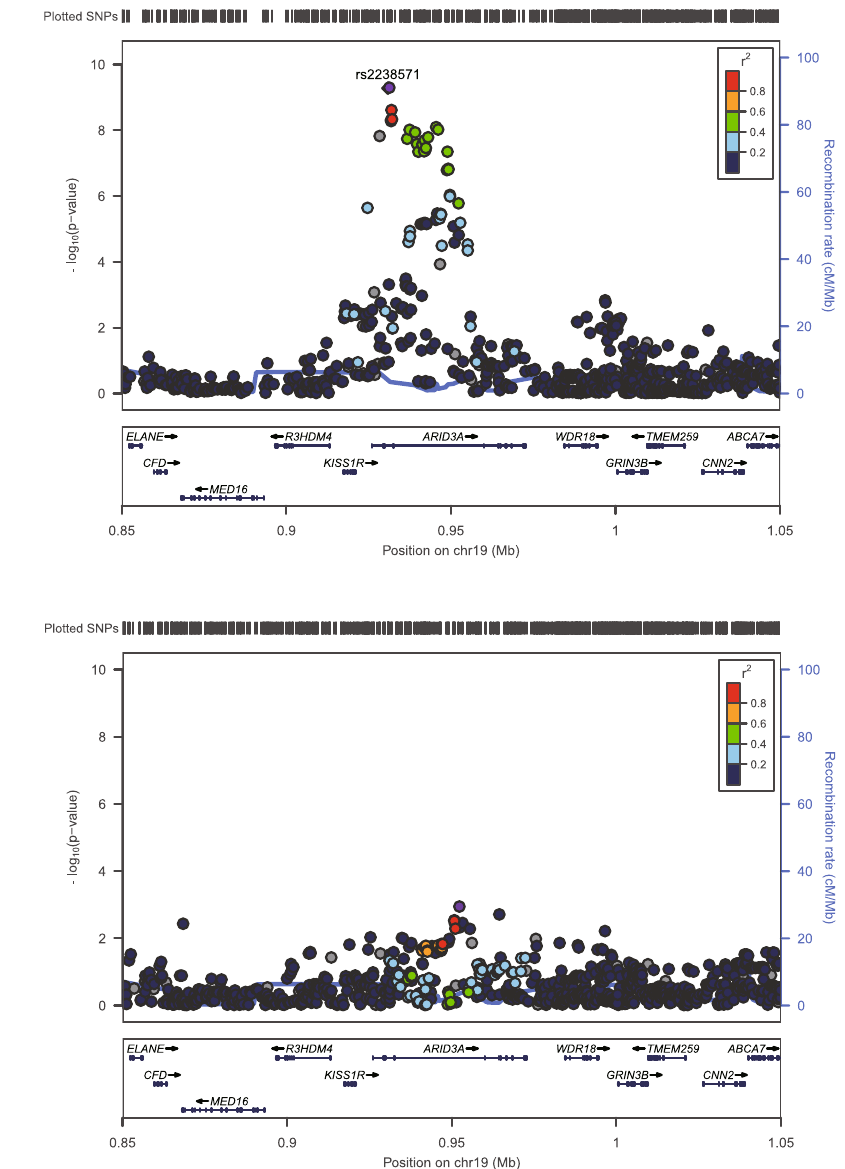
Fig. 1 | Meta-analysis ofPBC associationat19p13.3. A Regionalassociation plotfor19p13.3 centering onthe independent SNP,rs2238571 (purplediamond). B Regional association plot showing the association between genetic variants and PBC at 19p13.3 after conditioning on the lead